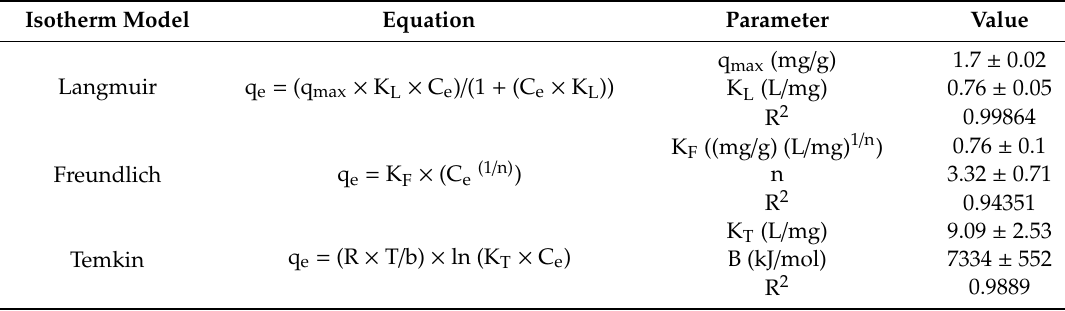
Table 2. Nonlinear isotherm models for the adsorption of DFC onto Cosmos (sample